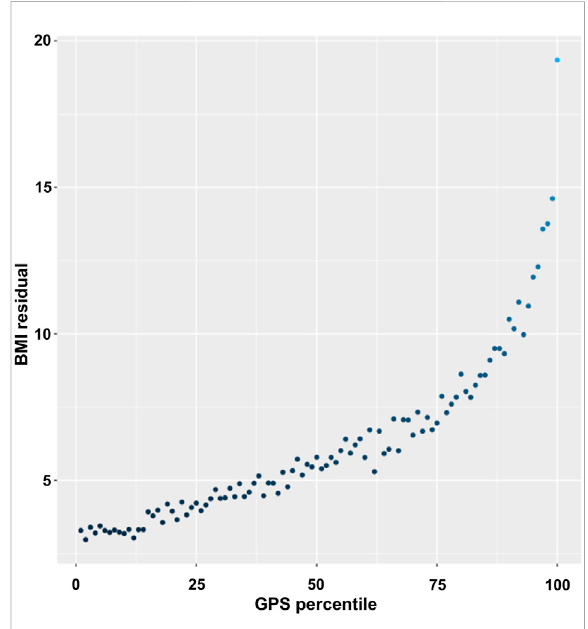
FIGURE 2 Plot of BMI residuals by GPS percentile. Samples were binned into 100 equally sized groups by GPS. In each group, the mean of residualsofBMIwascalculatedandplottedagainstthemeanvalue of GPS in the GPS percentile